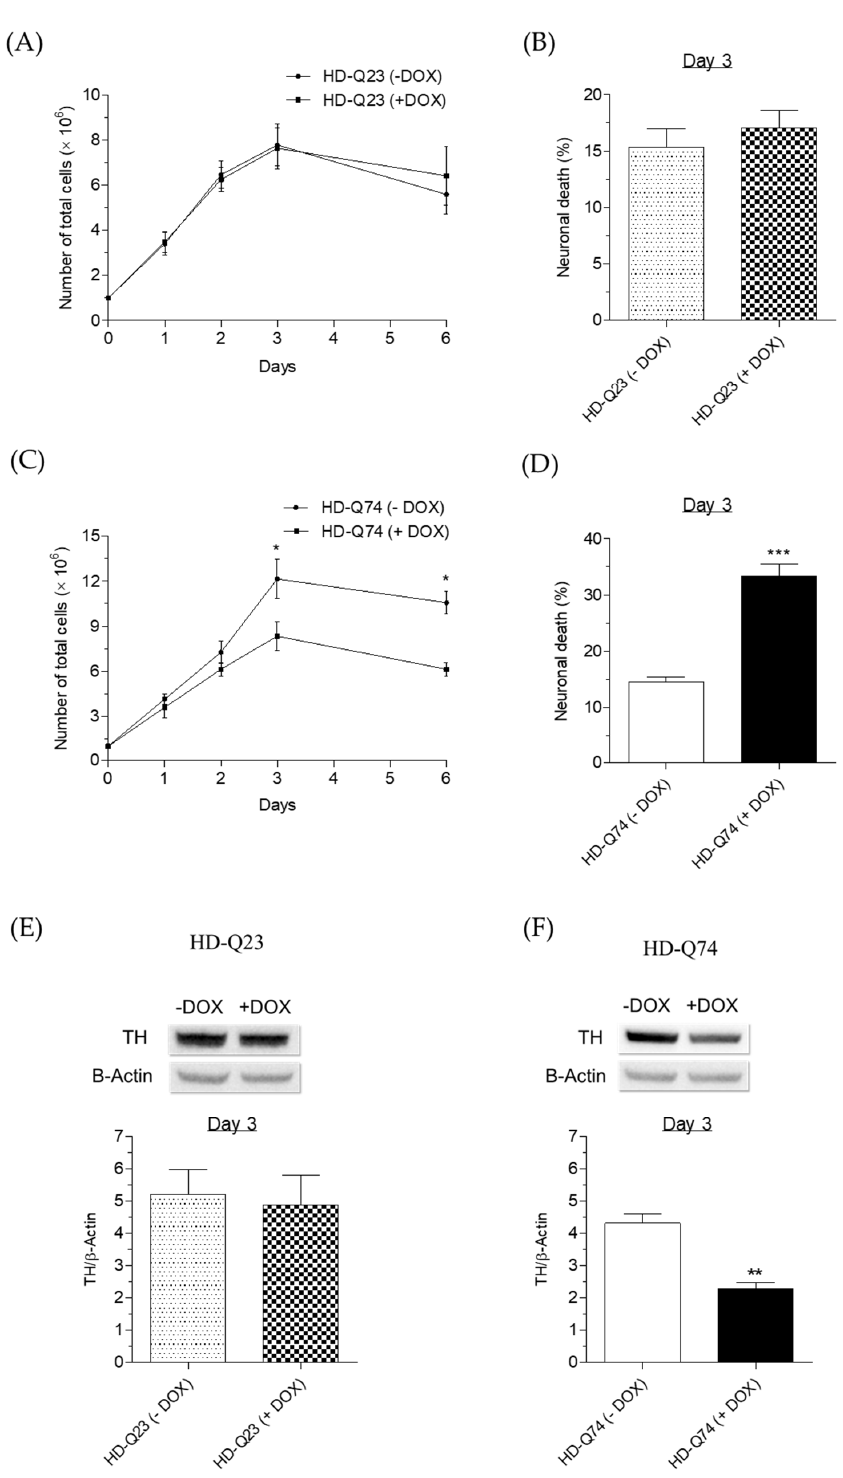
Figure 1. Neurotoxicity onset upon induction of mHTT in HD-Q74 cells. ( A , C ) HD-Q23 and HD-Q74 cells were incubated with DOX (1 µg/mL) for different times (1, 2, 3 and 6 days) and the cell proliferation was evaluated using eosin as described in the Materials and Methods. Data are expressed as numbers of total cells and reported as the mean ± SEM of at least three independent experiments (* p < 0.05 vs. HD-Q74 (- DOX) at one-way ANOVA with Bonferroni post hoc test); ( B , D ) HD-Q23 and HD-Q74 cells were incubated with DOX (1 µg/mL) for 3 days and neuronal death